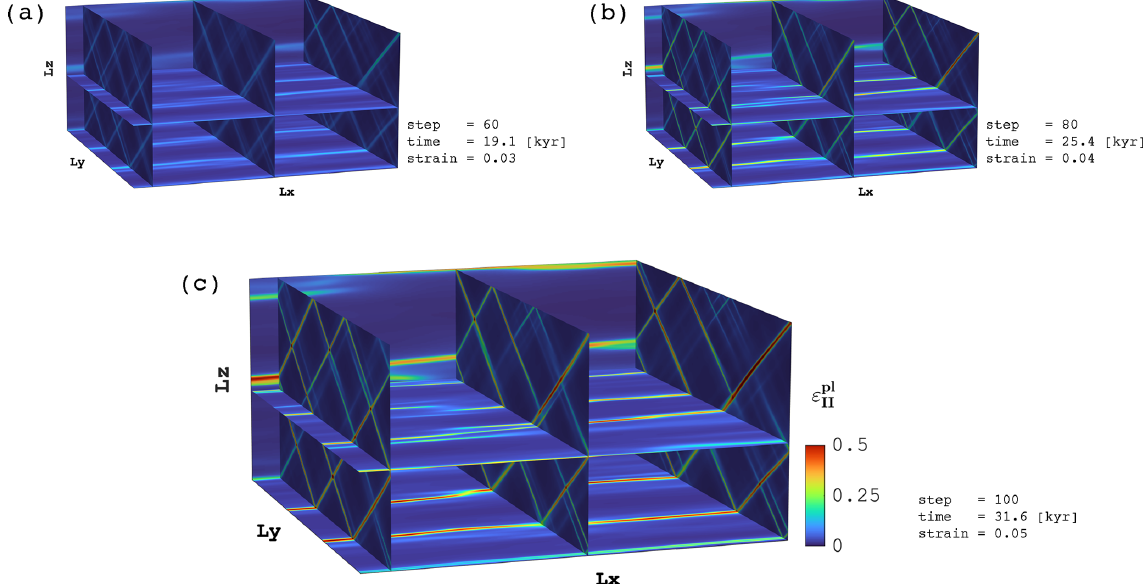
Figure 16. Total accumulated plastic strain ε pl distribution for a multi-GPU replica of the 2D calculation (Fig. 15b) resolving 3D shear-band II formation out of a random noise cohesion field. The numerical resolution includes 378 × 378 × 192 grid cells. Panels depict elasto-plastic shear-band formation after (a) 60 steps (corresponding 19.1kyr and a strain of 0.03), (b) 80 steps (corresponding 25.4kyr and a strain of 0.04) and (c) 100 steps (corresponding 31.6kyr and a strain of